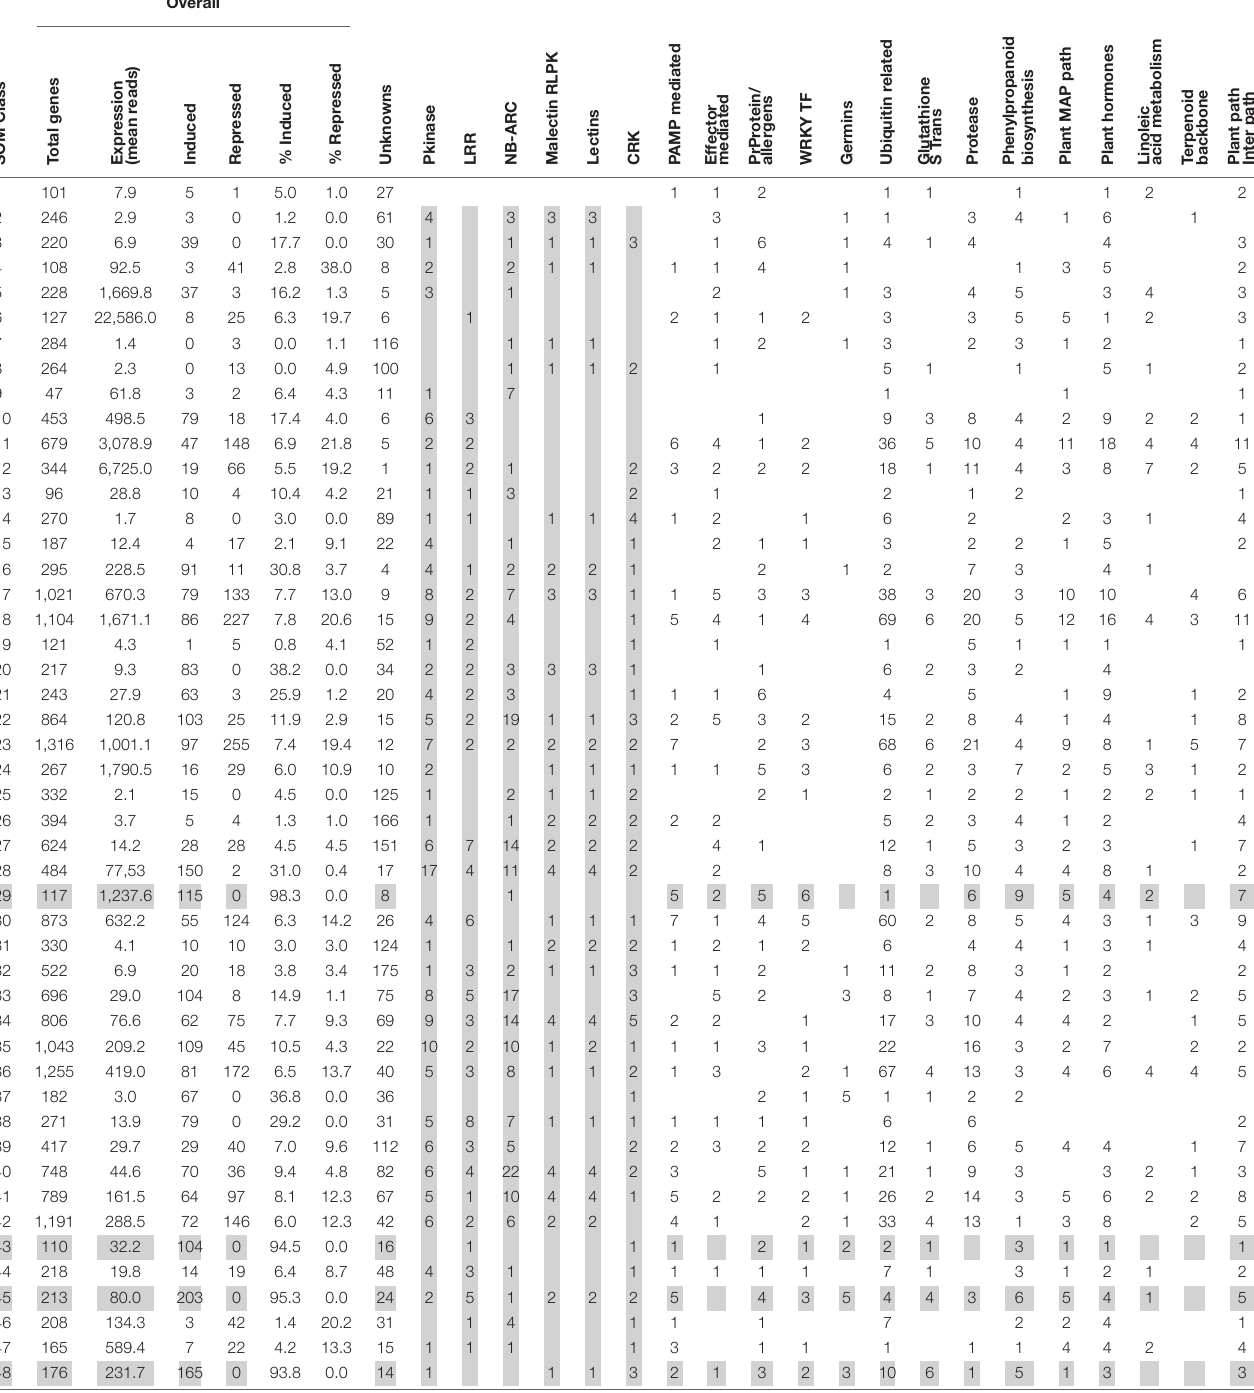
Shaded rows indicate SOM classes where genes were predominantly induced by Ppal infection and the shaded columns indicate gene groups associated wih signal perception.